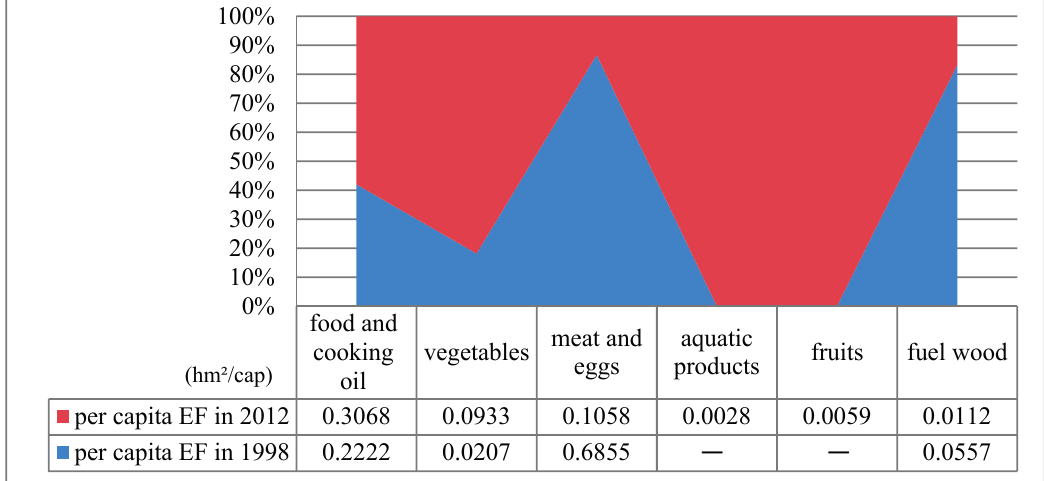
Figure 3. The EFs’ percentage accumulation areas of various types of biological product consumption before and after the Green for Grain Project (1998 and